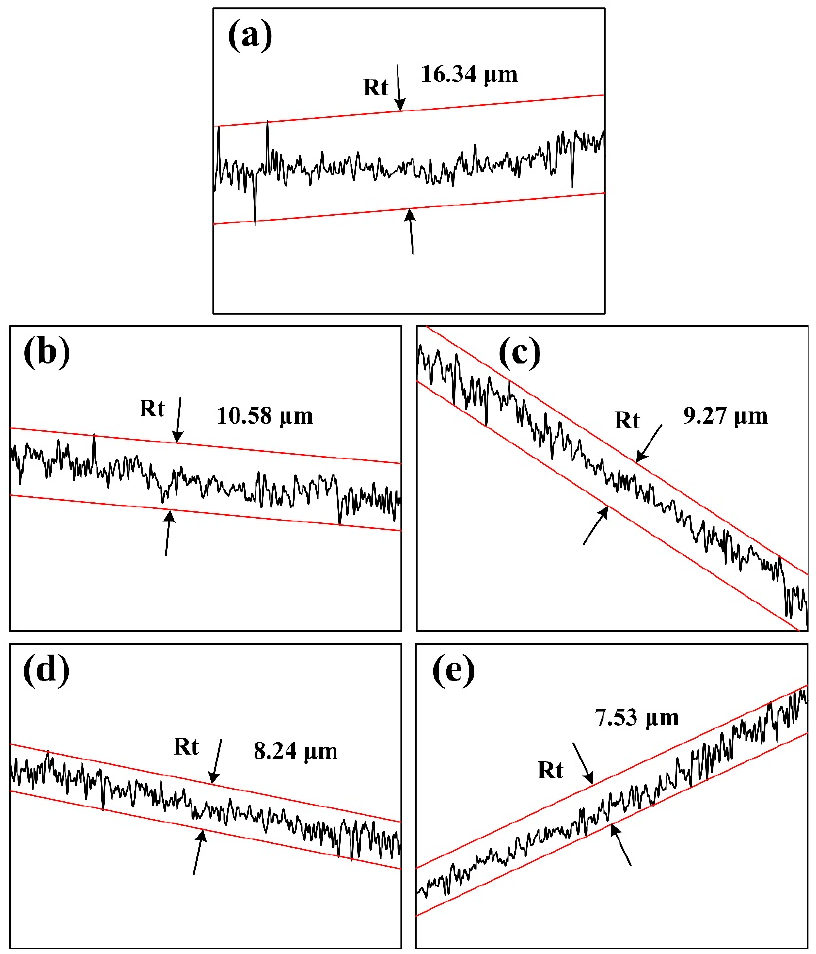
Figure 10. The roughness curves of ( a ) Al-4.7Cu-0.32Mg-0.44Si alloy and (TiC-TiB 2 )/Al-4.7Cu- 0.32Mg-0.44Si composites with TiC-TiB 2 particles content of ( b ) 10 wt.%, ( c ) 20 wt.% ( d ) 30 wt.% and ( e ) 40 wt.% under 5 N load and 13 μ m Al 2 O 3 abrasive size.